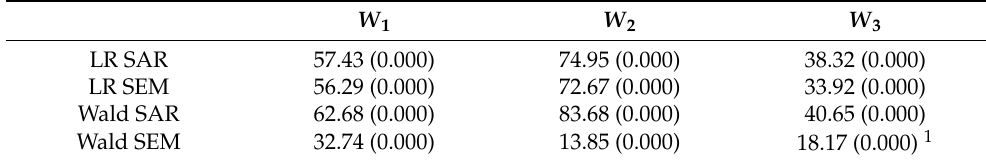
Table 7. The results of LR and Wald tests.